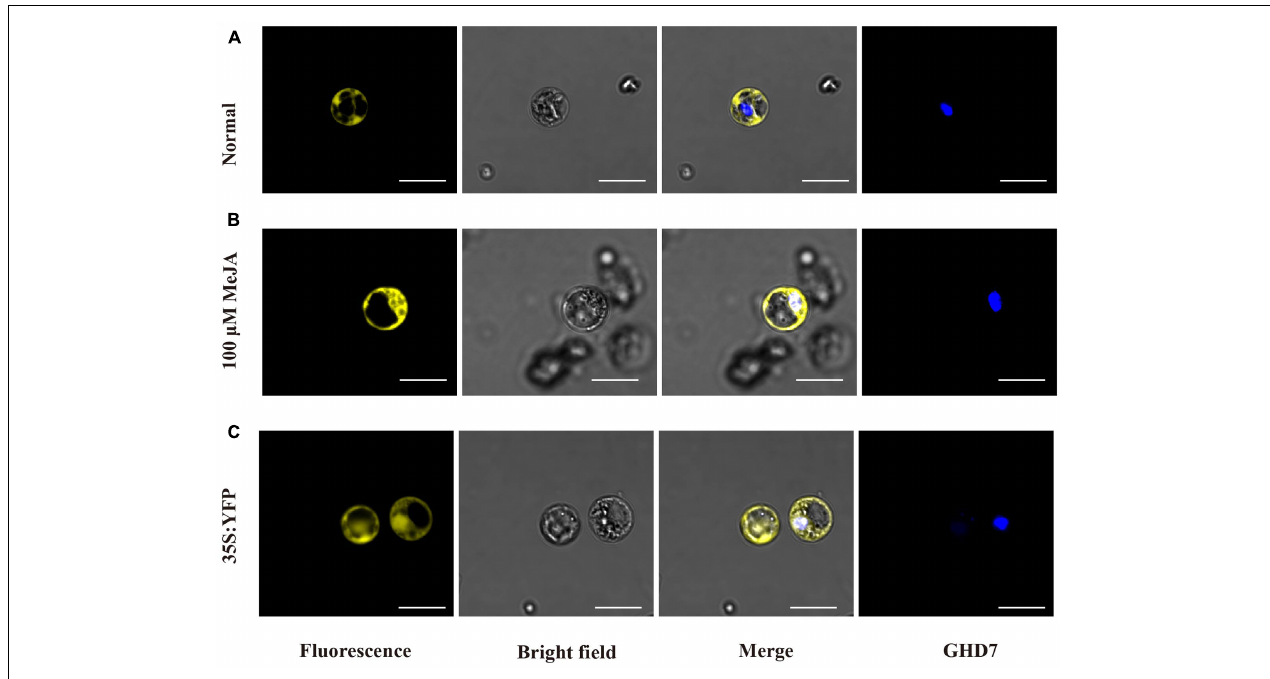
FIGURE 5 | OsJAZ1 subcellular localization. (A,B) Confocal microscopy of OsJAZ1-YFP localization in rice protoplasts under normal conditions and 100 µ M MeJA treatment, respectively. (C) 35S: YFP (PM999-YFP) was transformed into rice protoplasts as a control. GHD7 was used as a nucleus marker. Bars = 20 µ